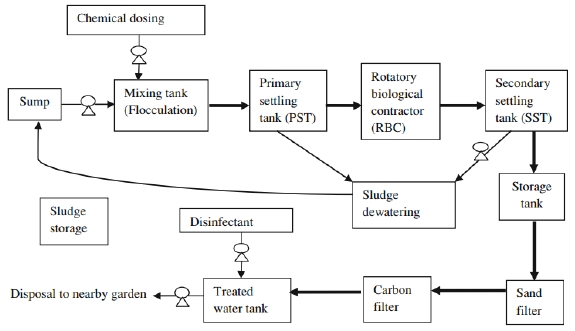
Figure 3. Process flow diagram of a small WWTP [94].